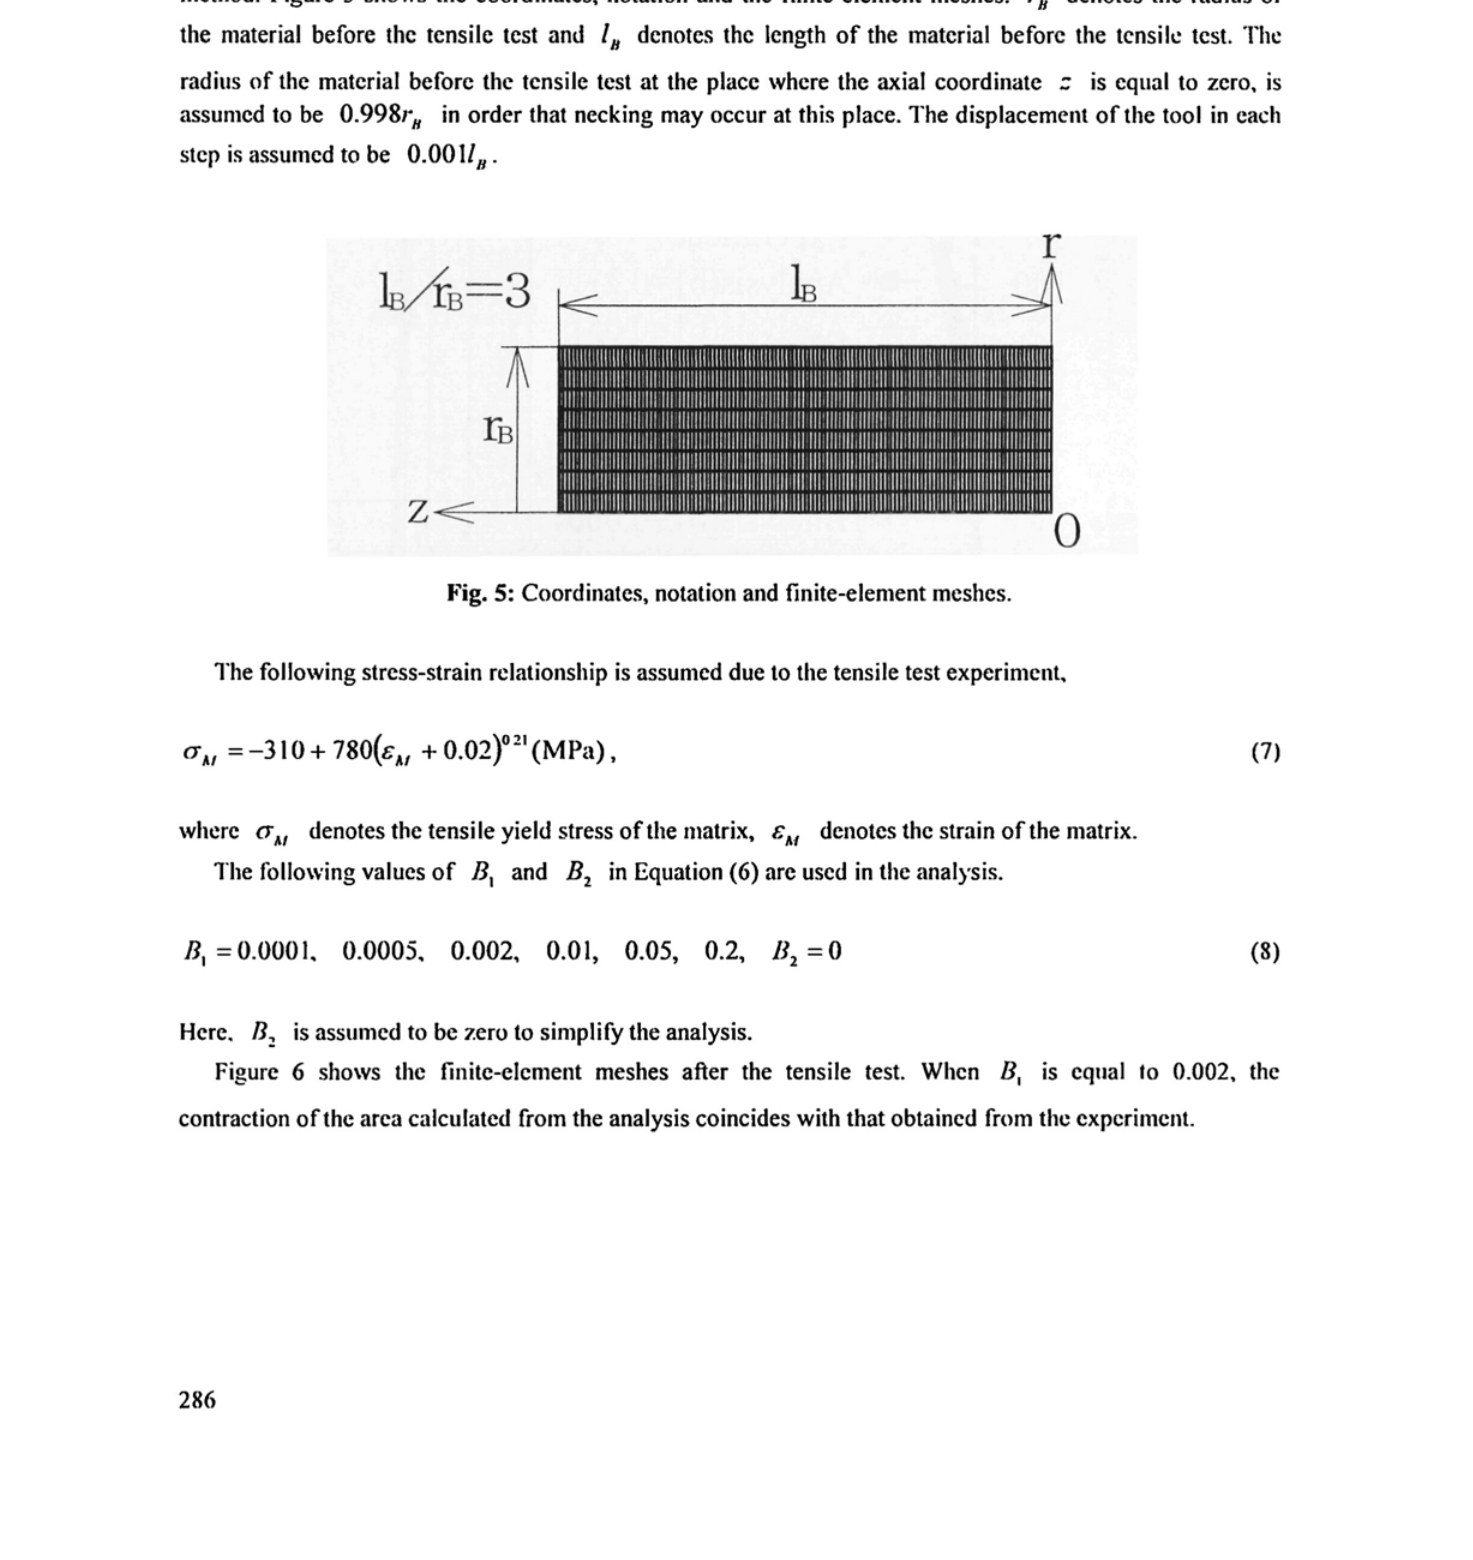
Fig. 5: Coordinates, notation and finite-element